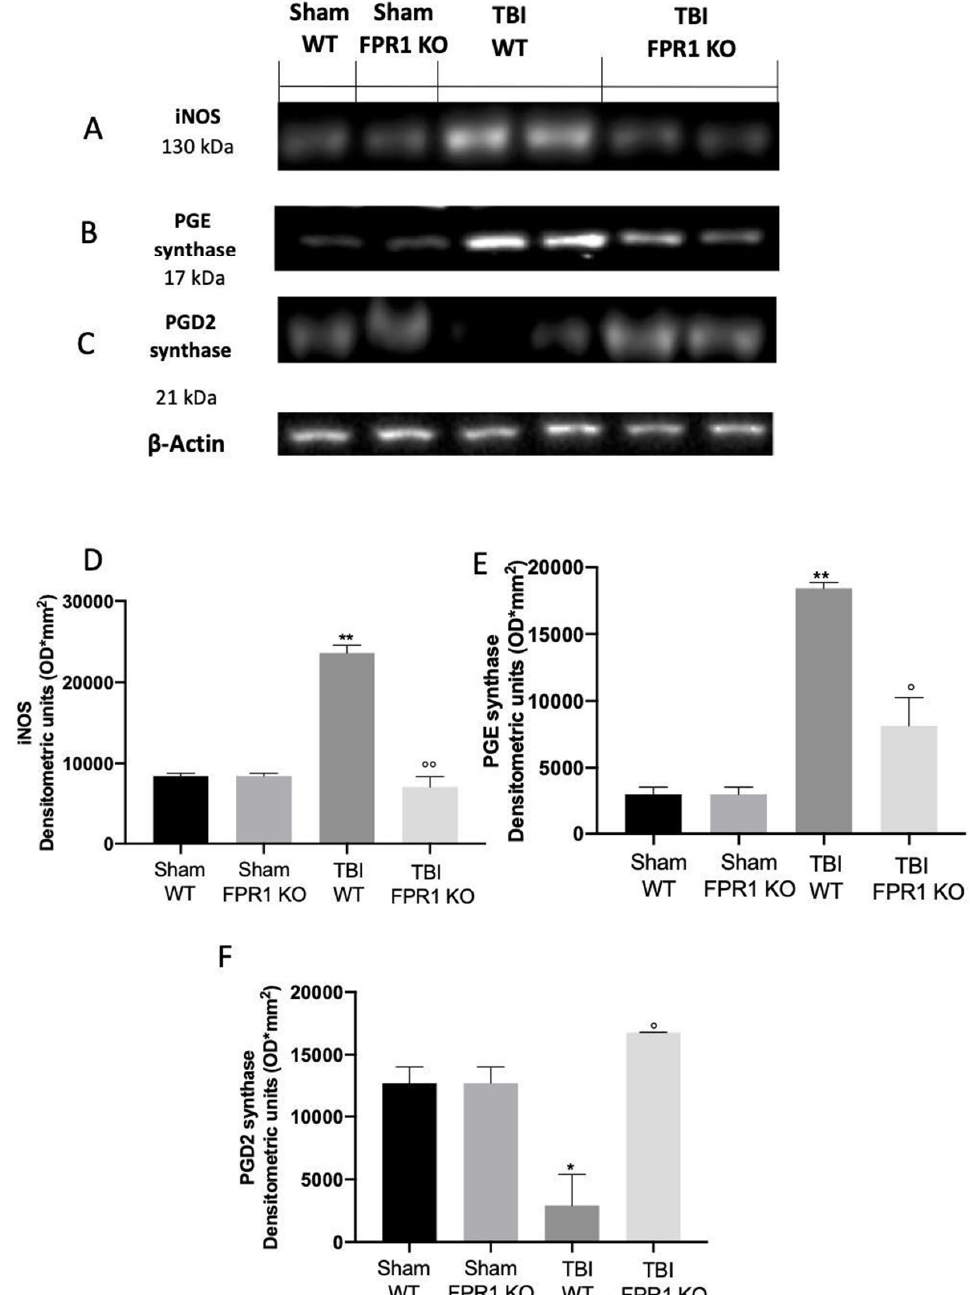
Figure 12. E ff ect of the absence of Fpr1 on iNOS, PGE2 and PGD2 synthase: Western blot analysis reveals increased iNOS levels in TBI WT mice compared to the Sham WT and Fpr1 KO animals ( A ) Tissues from TBI Fpr1 KO mice do not show any upregulation. Molecular analysis shows an increased PGE2 synthase ( B ) expression in TBI WT mice compared to the Sham WT and Fpr1 KO animals, while TBI Fpr1 KO animals do not show any increase. PGD2 synthase expression ( C ) decreases in WT animals four weeks after TBI, compared to the Sham WT and Fpr1 KO animals. In the TBI Fpr1 KO animals, PGD2 synthase expression remain at the basal levels; see the densitometric analysis ( D – F ) For the analyses, n = 5 animals from each group were employed. Results were analyzed by two-way ANOVA followed by a Bonferroni post-hoc test for multiple comparisons. Non-parametric data were analyzed with Fisher’s exact test. * p < 0.05 vs. Sham WT; ** p < 0.01 vs. Sham WT; ◦ p < 0.05 vs. TBI WT; ◦◦ p < 0.01 vs. TBI